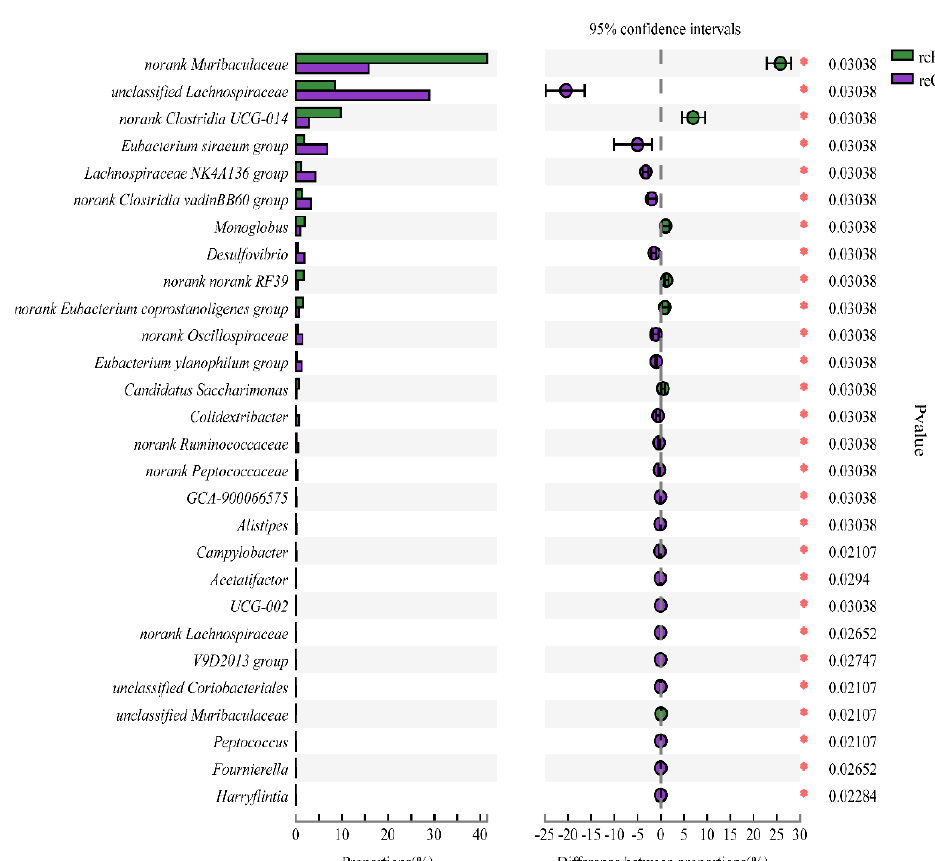
Figure A4. Wilcoxon rank–sum test bar plot at the genus level for the comparison of the microbiota in the cecum. The relative abundances of seven genera were tested and found to be significantly different between the cP and cG groups. * 0.01 < p < 0.05.